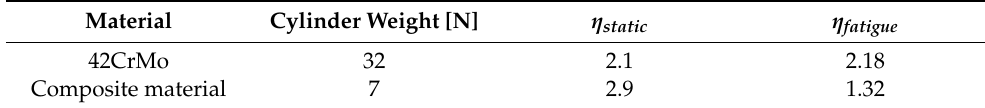
Table 14. Comparison of safety factors for steel and composite